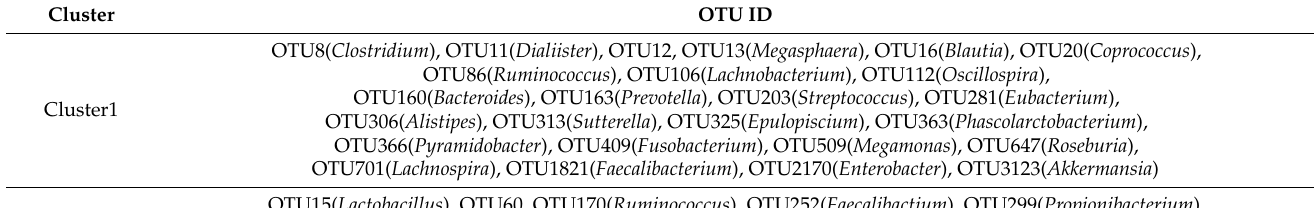
Table A3. OTUs contained in each Cluster after